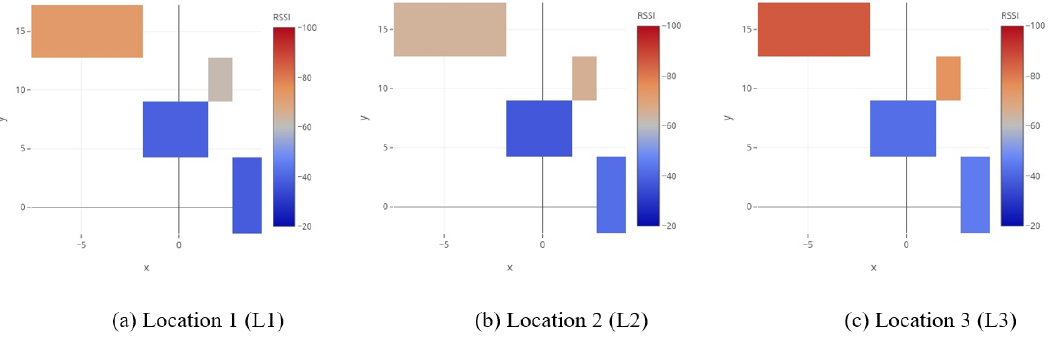
Figure 7. Received signal strength indication (RSSI) heat